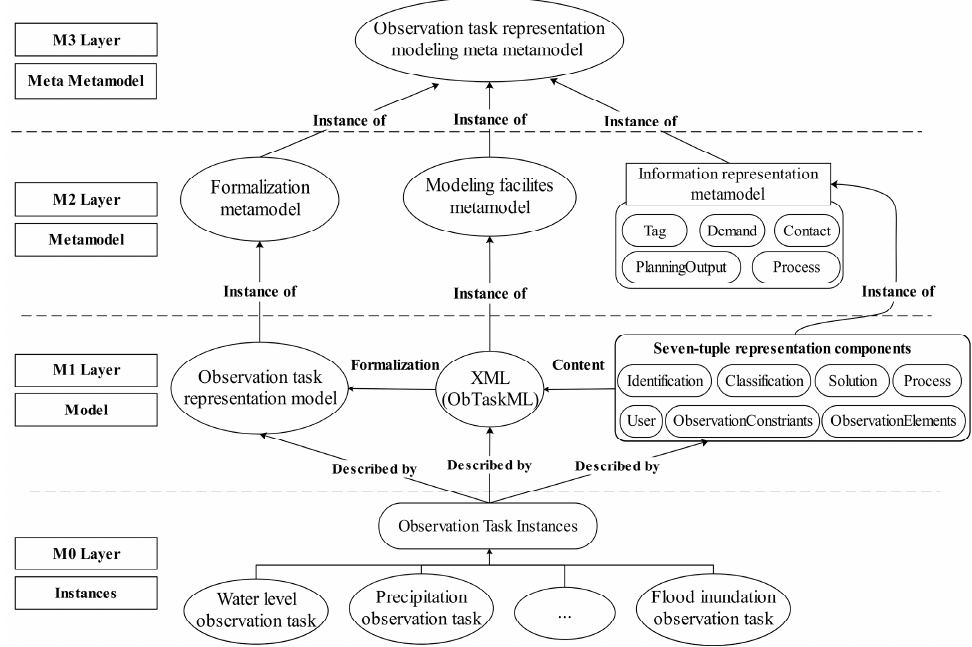
Figure 2. Earth observation task representation of the metamodeling architecture.